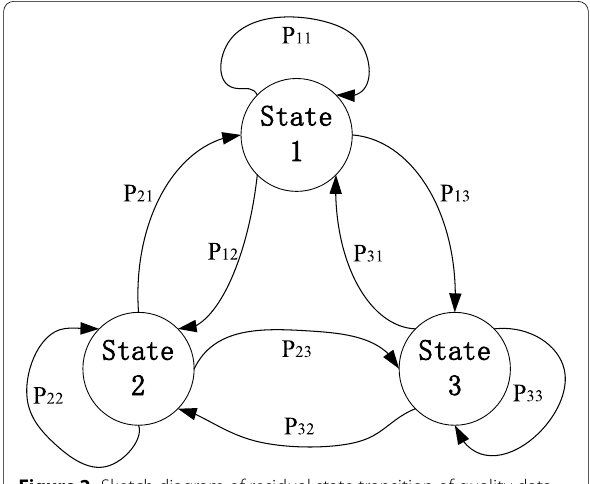
Figure 2 Sketch diagram of residual state transition of quality data